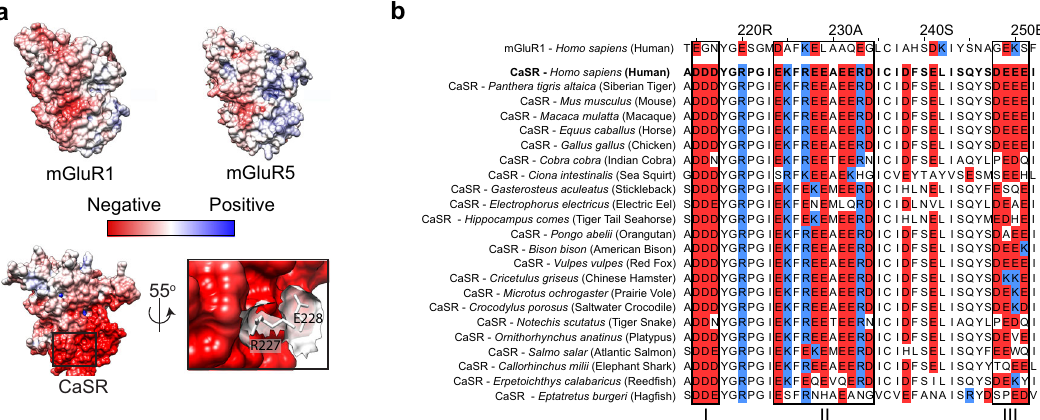
Fig. 6 The highly negative charge of the CaSR dimer interface is variable. a Electrostatic potential map of mGluR1 (top left, PDB 1ISR), mGluR5 (top right, PDB 3LMK), and CaSR (bottom left, PDB 5K5S). Close up inset of CaSR (bottom right) showing stick and surface representation of R227 and E228 at the lower lobe interface. b Multiple sequence alignment of mGluR1, CaSR, and select CaSR orthologs with negatively charged residues (red) and positively charged residues (blue) highlighted. CaSR is used as reference for residue numbering. Boxes indicate regions of high charge density unique to